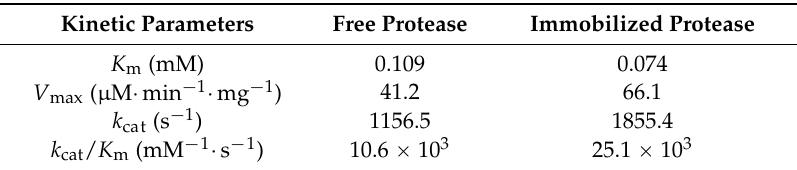
Table 2. Kinetic parameters of free and immobilized NPST-AK15 alkaline protease. The standard deviations were in the range of 1.5%–3.1%.